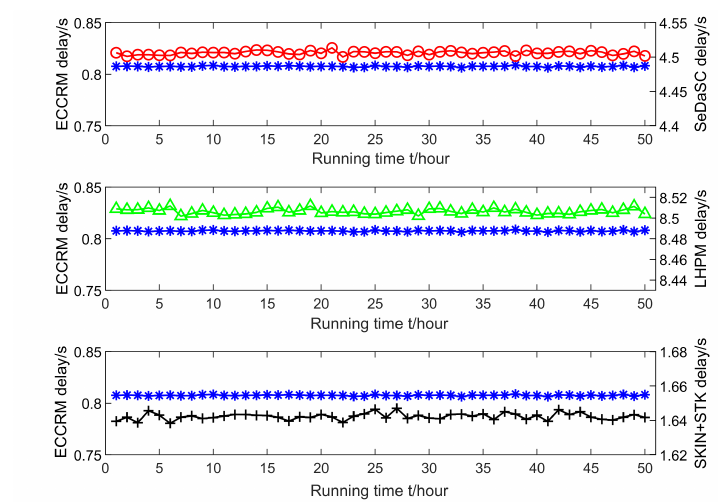
Figure 14. Comparison of algorithm stability.